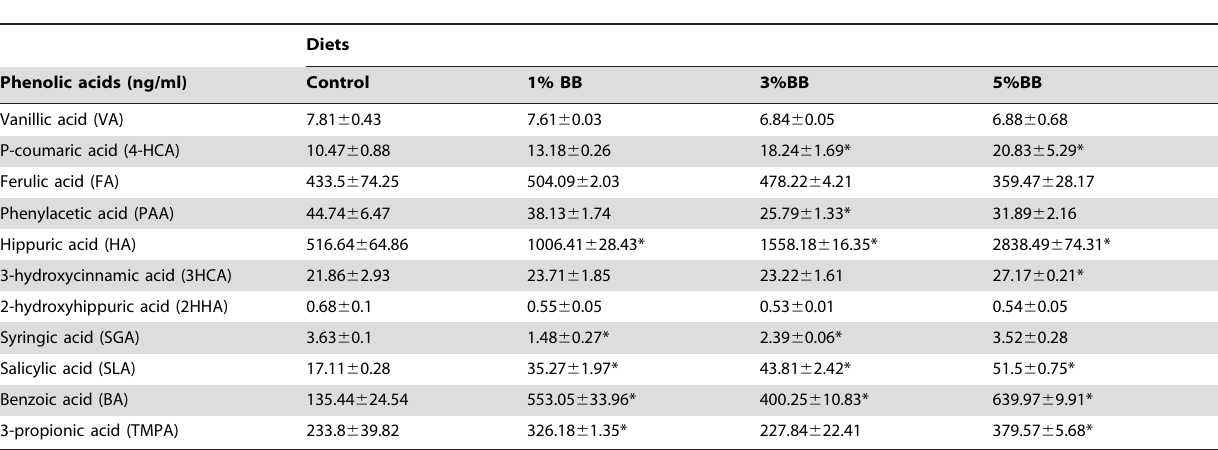
Table 3. The concentration of eleven phenolic acids present in serum of both the control and BB diet fed rats.